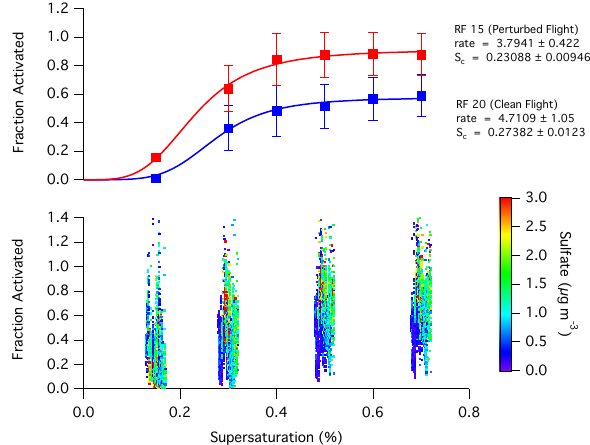
Fig. 6. CCN spectra showing the activation of particles at various supersaturations. The top panel is CCN data from a perturbed flight (red markers, RF 15) and clean flight (blue markers, RF 20) fitted to a sigmoidal curve of the form CCN/CN = a 0 /(1+( x/a 1 ) − a 2 ) where a 0 , a 1 and a 2 are fitted parameters. The error bars represent the measurement standard deviation. The bottom panel shows all CCN measurements made over the course of the campaign at 0.15, 0.3, 0.5 and 0.7%